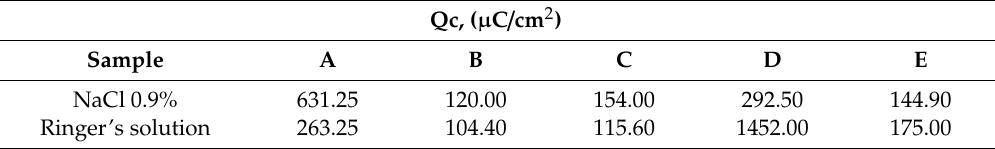
Table 6. Critical electric charge densities, Qc, in NaCl 0.9% and Ringer’s solution.